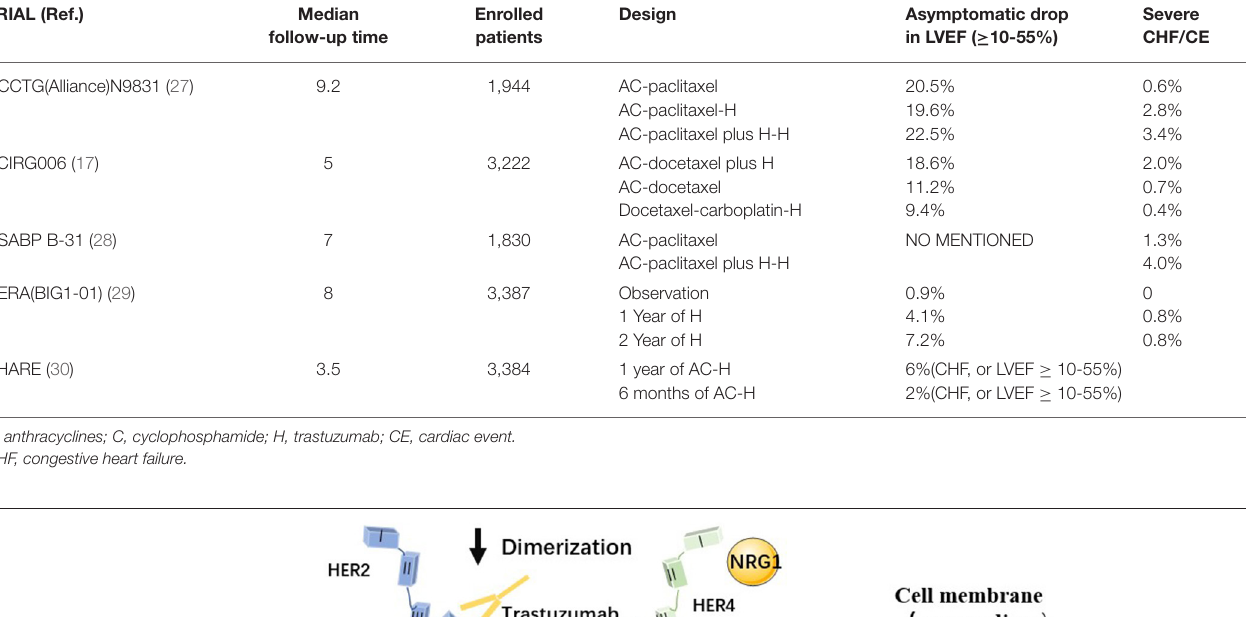
that trastuzumab increases cardiotoxicity when combined with anthracyclines (46,